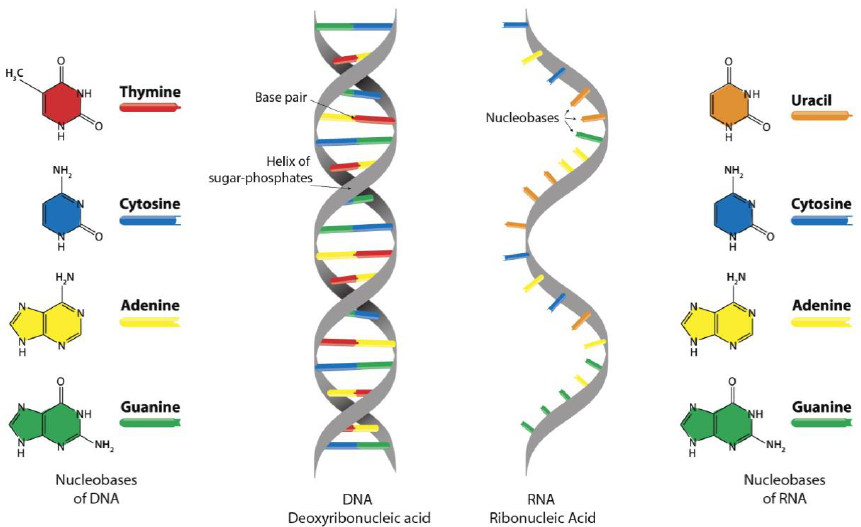
Figure 3. Scheme about chemical structure of natural polymers and their main generic functions.